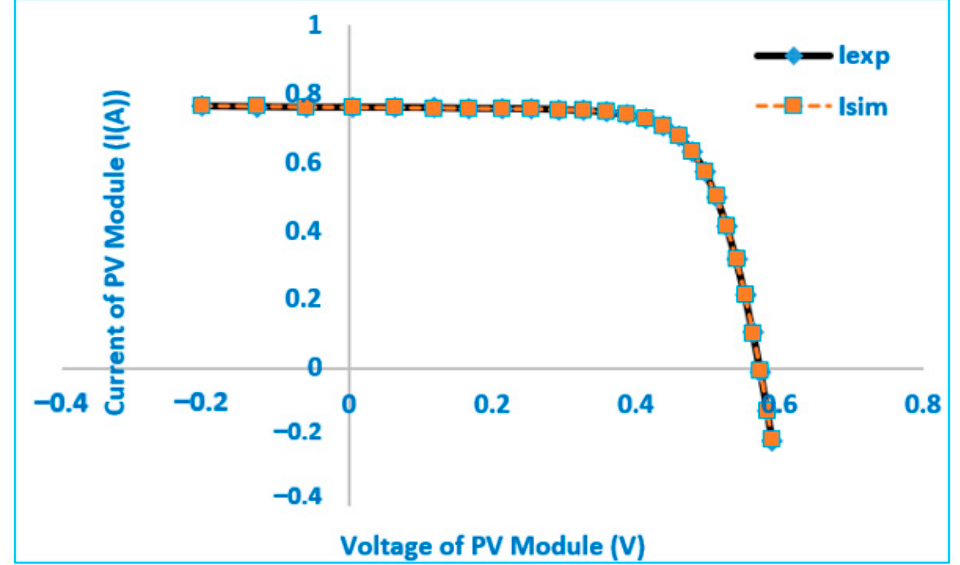
Figure 14. I–V characteristics of the proposed HPO technique for the triple-diode of RTC France PV cell.